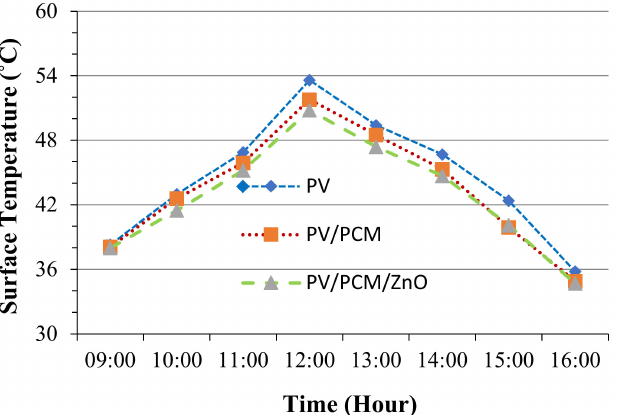
Figure 5. Variation of module surface temperature of the PV, PV with PCM, and PV with ZnO- doped PCM.